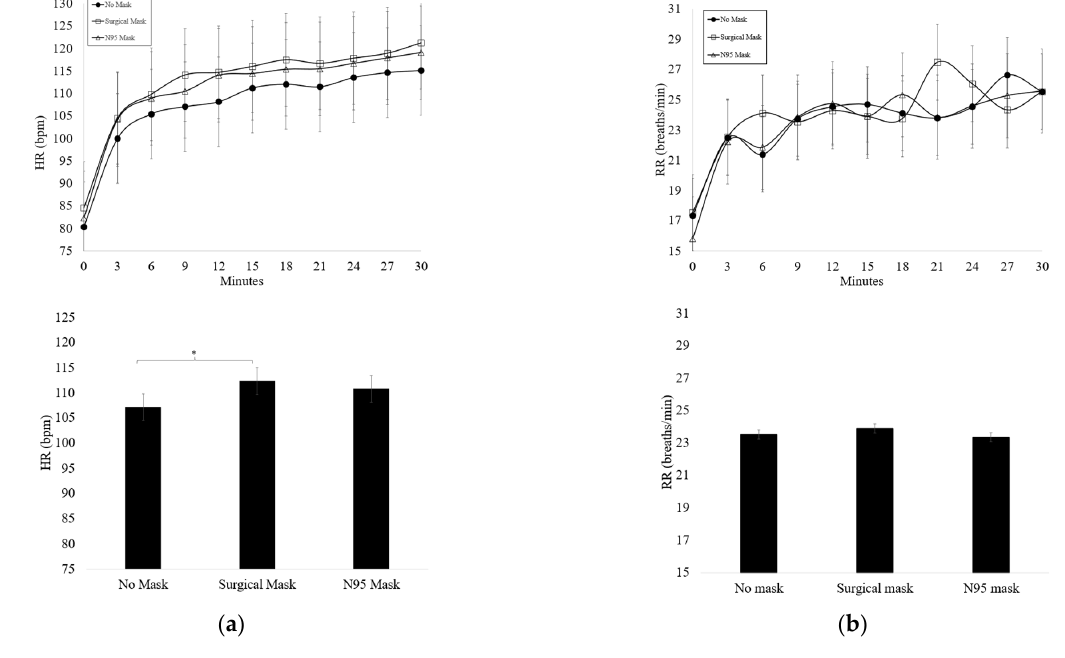
Figure 2. ( a ) Average heart rate (HR) (mean ± SD) during each testing condition ( n = 19) * Significant main effect for condition ( p < 0.05); ( b ) average respiratory rate (RR) (mean ± SD) during each testing condition ( n = 19).